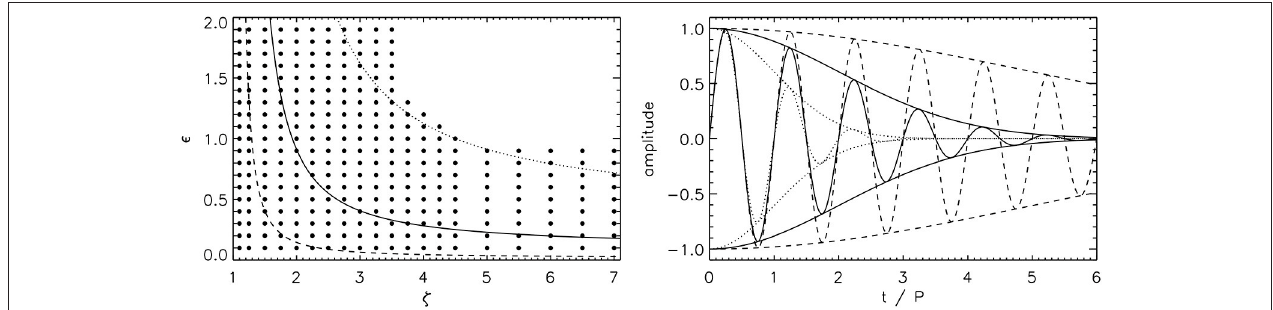
FIGURE 2 | The black circles denote the 300 numerical simulations that comprise version 1.0 of our LUT. The solid, dashed, and dotted lines correspond to the damping rates shown in the right panel. These damping profiles are based on the TB approximation for the Gaussian damping profile but serve as an indication of the range of parameters we are interested in considering with respect to observational